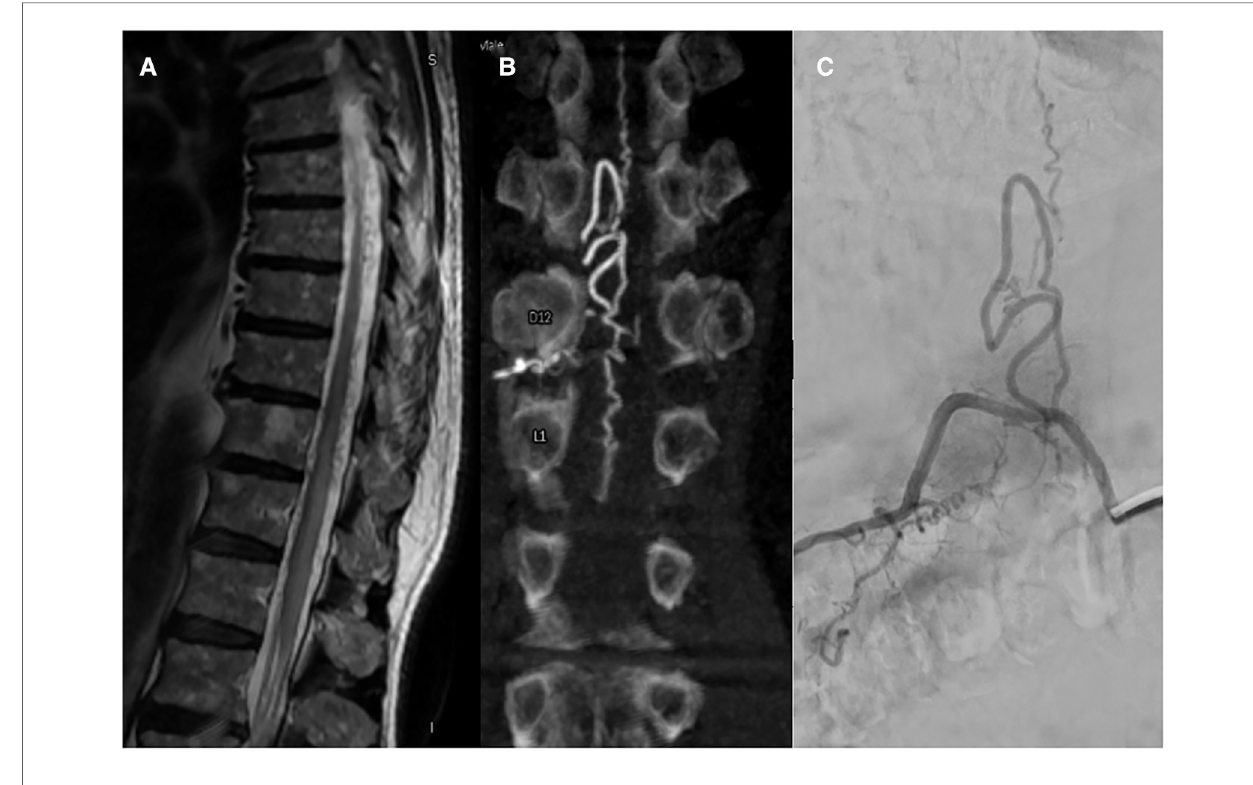
FIGURE 1 Right D12 dural arteriovenous fi stula ( A ) MR; ( B ) VasoCT; ( C )